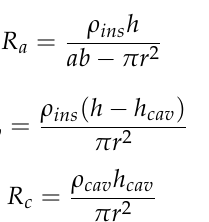
Table 7. Capacitive–Resistor Model’s Parameters (2 h, r).